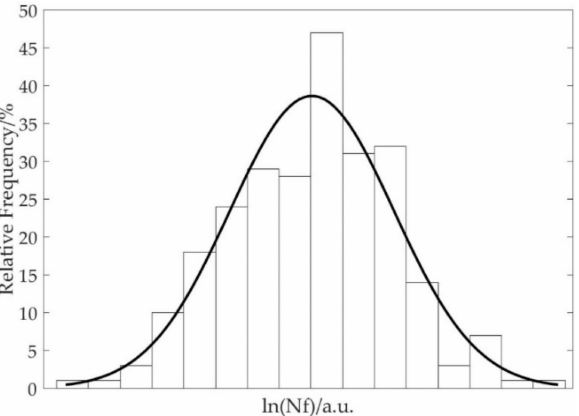
Figure 11. Distribution of predicted lives of the sealing bolts in logarithmic sale.